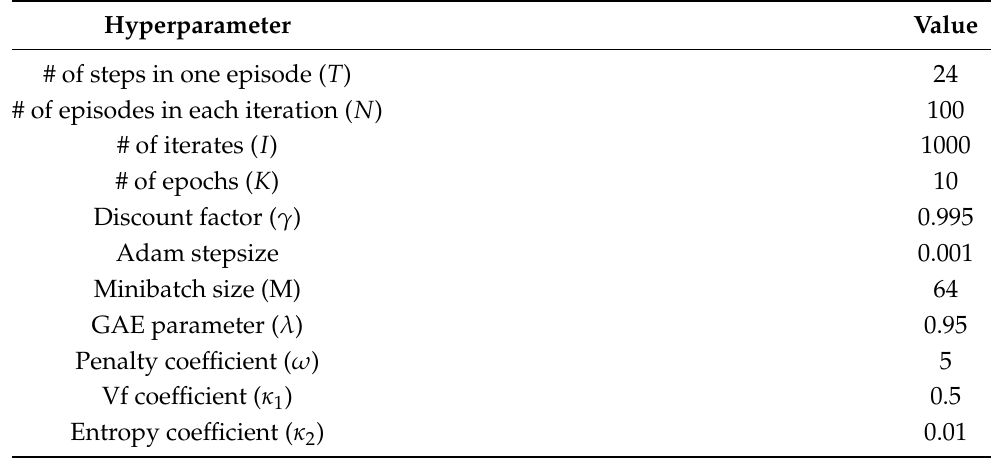
Table 2. Parameters of the PPO-based method for the Online Energy Scheduling